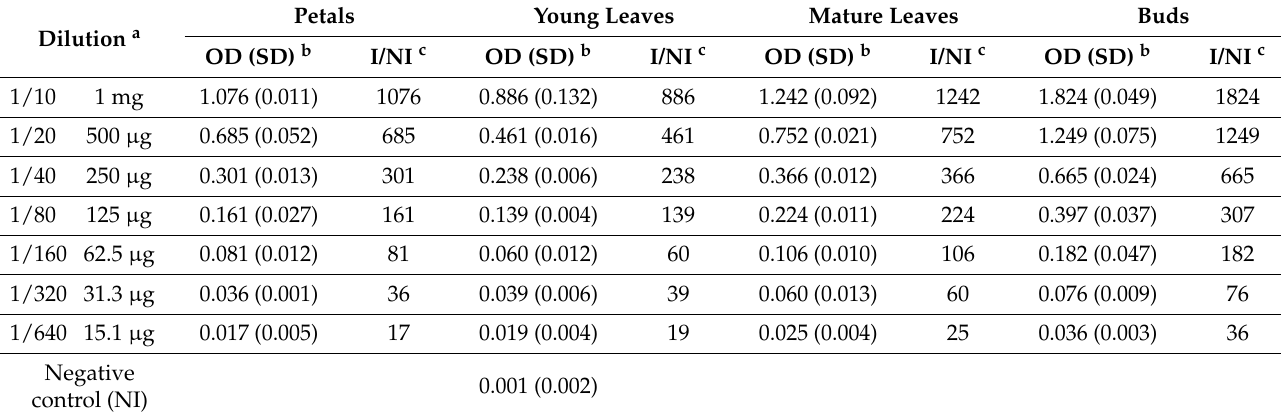
Table 4. Sensitivity of DAS-ELISA test in different apple tissues using the antiserum against NP protein of CCGaV. Dilution a